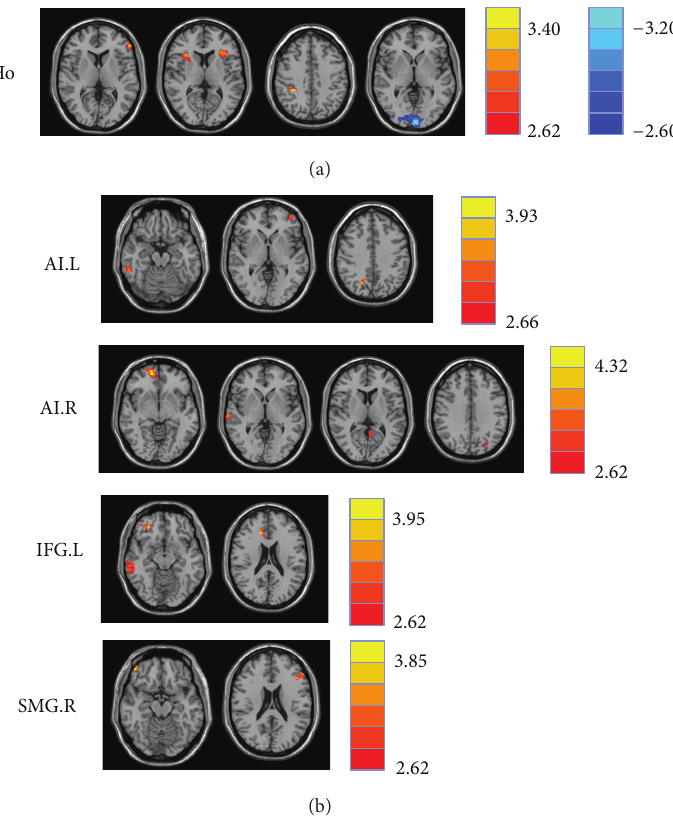
Figure 1: (a) Regions of significant ReHo differences in tinnitus patients compared with healthy controls. Heat map (upper, right) shows areas of increased ReHo ( 𝑡 values 2.62 to 3.40; red to yellow, resp.) and decreased ReHo ( 𝑡 values − 2.60 to − 3.20; dark blue to light blue, resp.). Table 3 identified regions where significant increases and decreases occurred. (b) Significant increased functional connectivity of four seed regions between tinnitus patients and healthy subjects. Table 4 identified regions where significant increases occurred. The threshold was set at 𝑃 < 0.01 (AlphaSim correction). L: left; R: right; ReHo: regional homogeneity; AI: anterior insula; IFG: inferior frontal gyrus; SMG: supramarginal gyrus.